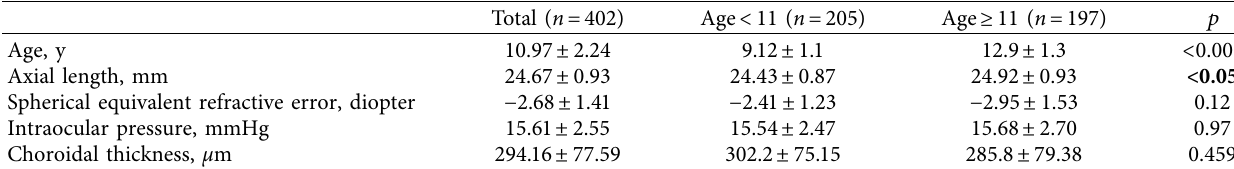
Figure 2: Choroidal thickness in micrometers versus location in myopic patients. The choroid was the thickest at the point 3mm temporal to the fovea and decreased nasally to a minimum at the point 3mm nasal to the fovea. Table 3: Comparison between age groups.